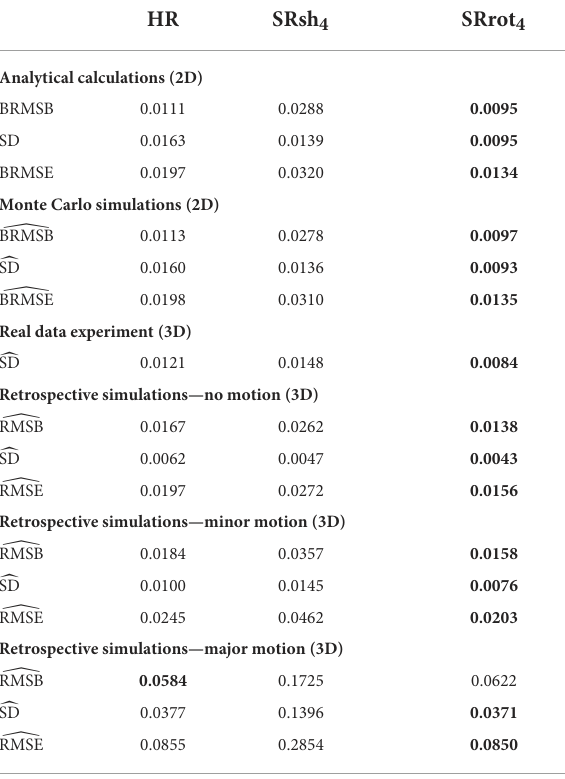
TABLE 2 Quantitative comparison results for the HR, SRsh 4 , and SRrot 4